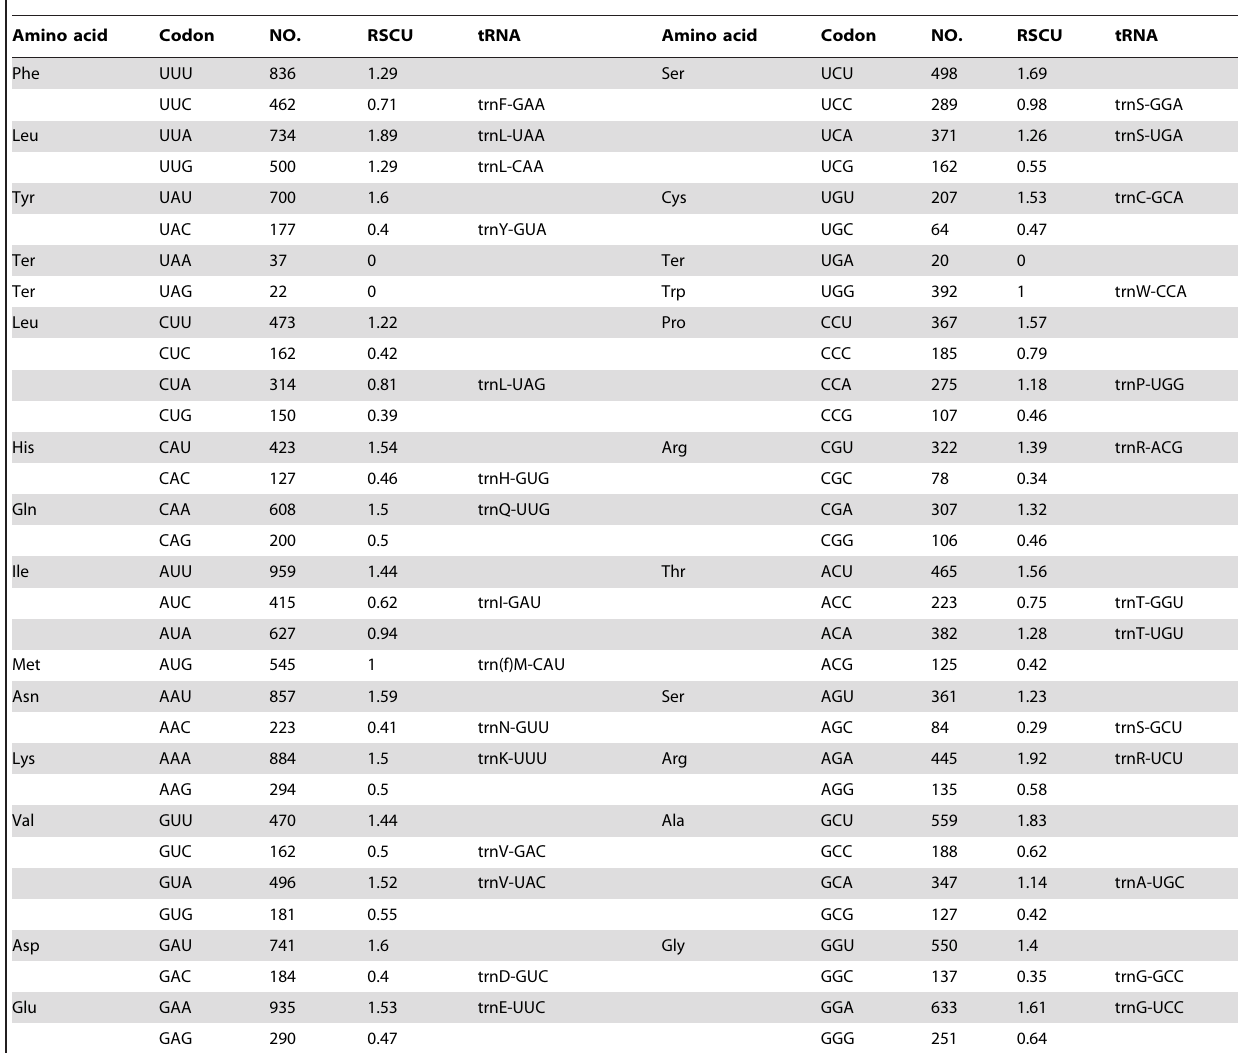
Table 1. Codon usage and codon-anticodon recognition pattern for tRNA in date palm chloroplast genome.